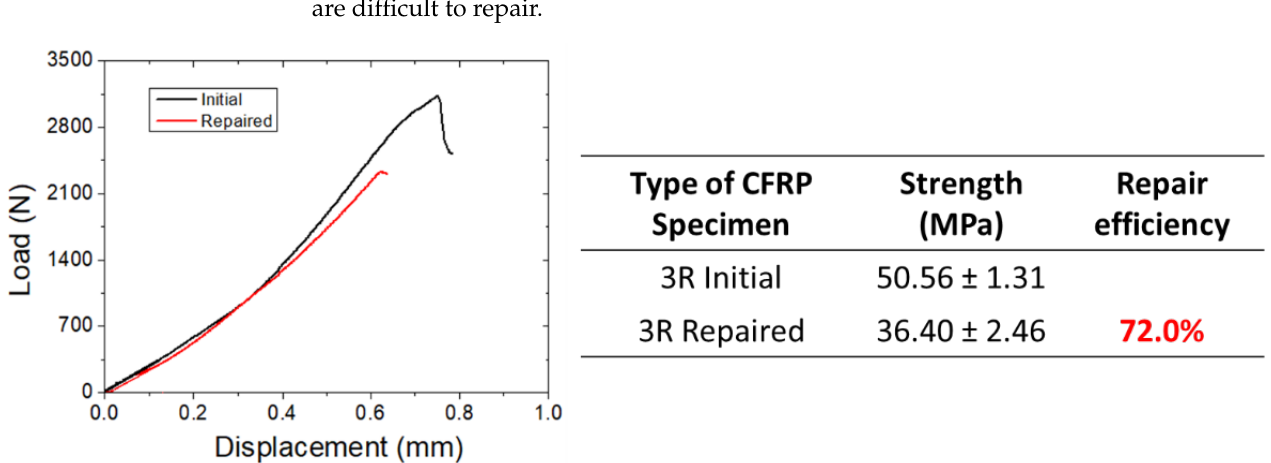
Figure 6. Representative plots of ILSS specimens ( left ) and repair efficiency of maximum strength ( right ).